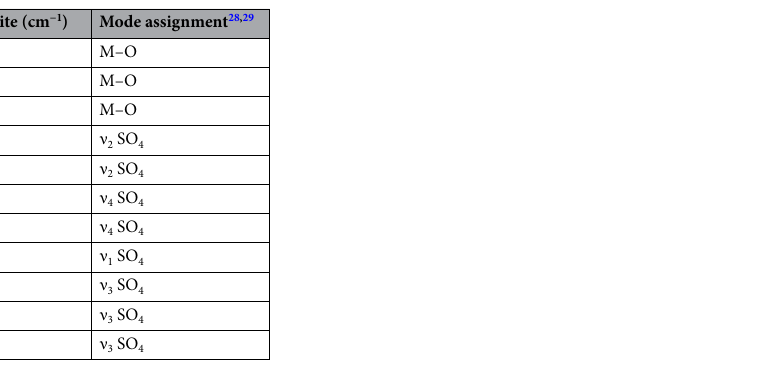
Table 3. The Raman vibrational modes in